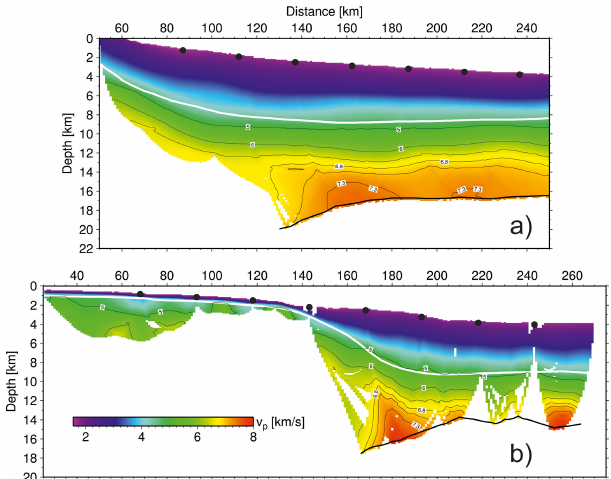
Figure 3. The resulting P -wave velocity models according to deep seismic refraction experiments along profile (a) line 1 and (b) line 3 of the South American margin. The location of the lines is shown in Fig. 1. The white line roughly resembles the 4.8kms − 1 isoline and marks the top of the basement, and the black line is the Moho. The basement depicts the breakup unconformity on the continental crust separating the crystalline basement from the postrift sediments and evolves eastwards into the top of the oceanic crust. Black points indicate OBH